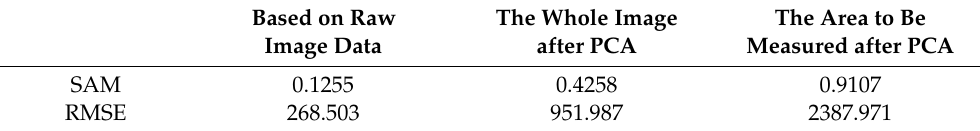
Table 2. Similarity comparison between the Mengshi car model and bush.